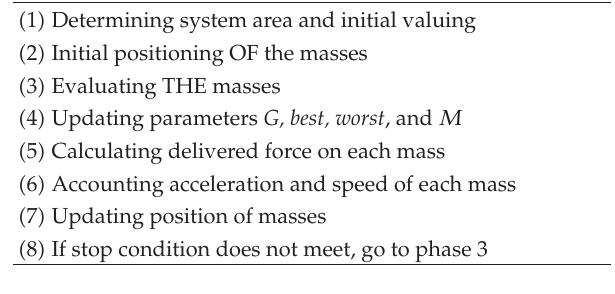
Table 2: Semi-code of gravitational